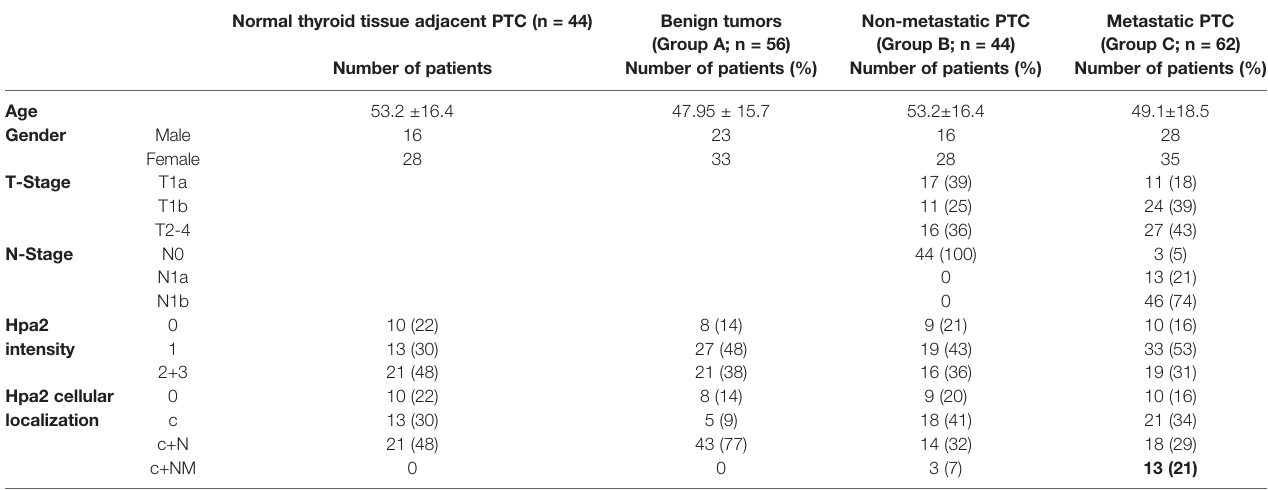
TABLE 1 | Demographic, pathology, staining intensity and cellular localization of Hpa2 in benign lesions (group A), non-metastatic (group B), and metastatic (group C) thyroid carcinoma. Normal thyroid tissue adjacent PTC (n = 44) Benign tumors (Group A; n =